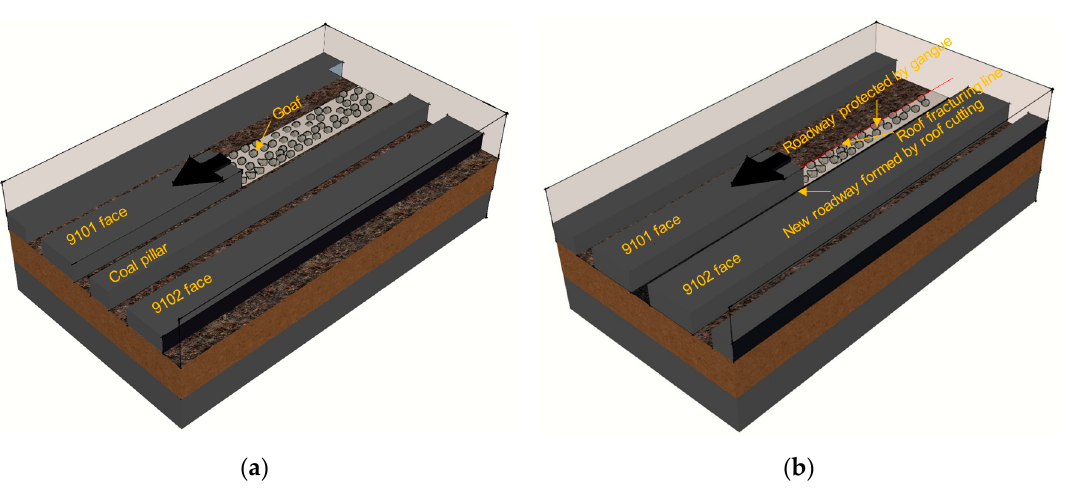
Figure 4. Technological process of GERRCP. ( a ) Strengthening roadway roof by constant-resistance large-deformation anchor cable (CRLDAC); ( b ) Pre-cracking roof cutting by energy-gathered blasting; ( c ) Gangue support; ( d ) Closing the goaf by shotcreting.